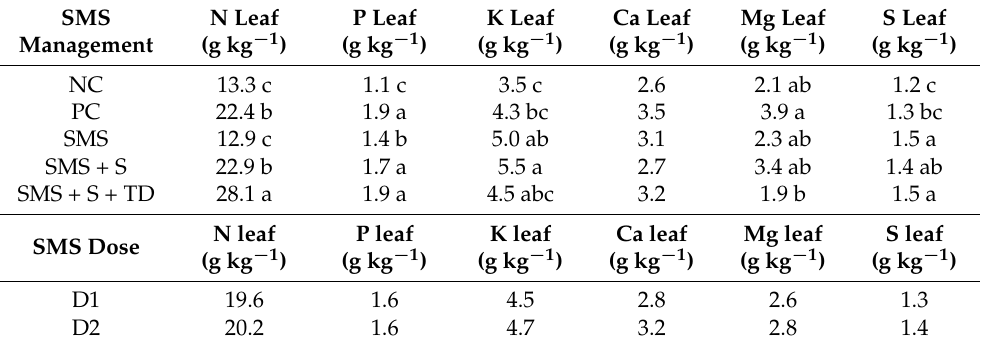
Table 5. Mineral composition of the last fully opened maize leaf collected at 70